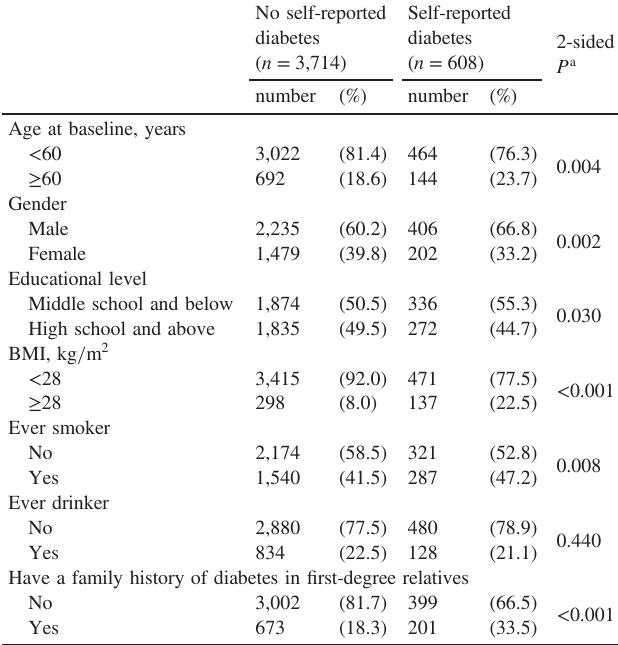
Table 1. Characteristics of subjects in validation study of self- reported type 2 diabetes in Shanghai ( n =